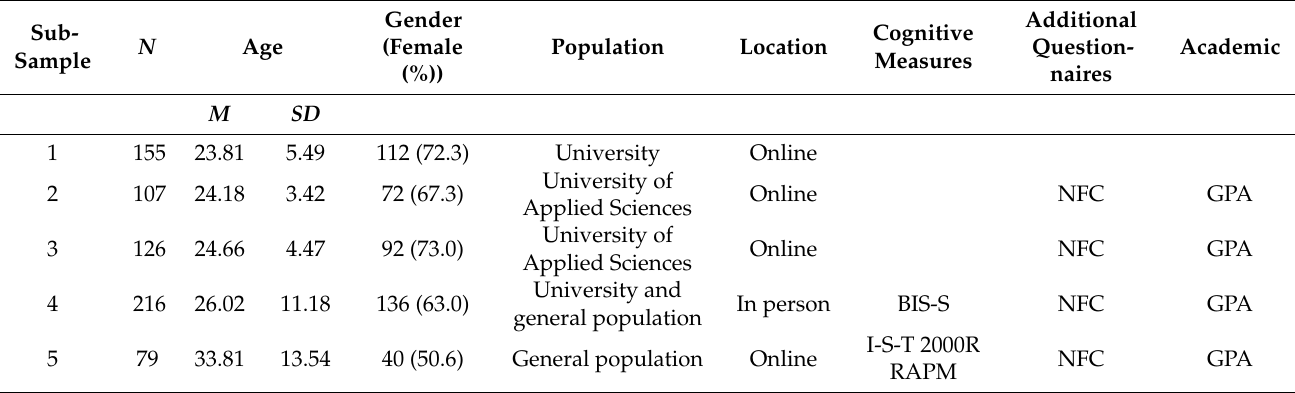
Table 1. Sub-sample specific demographics and assessed